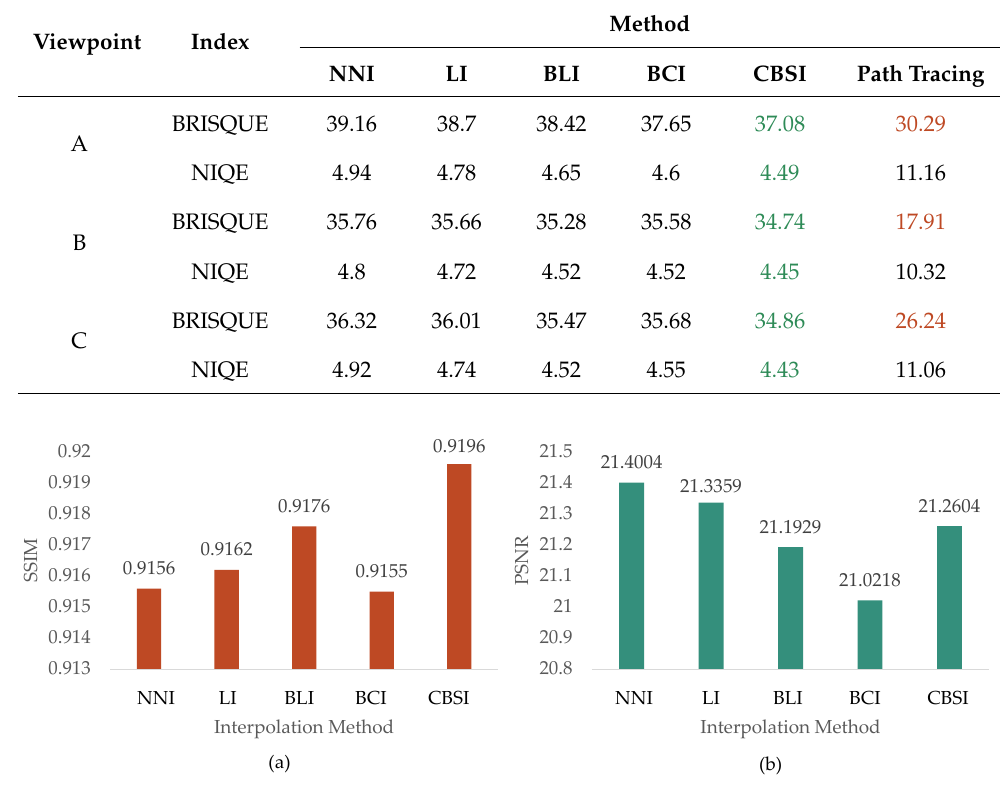
Figure 10. The comparisons between different interpolation methods and the path tracing rendering using ( a ) SSIM and ( b )